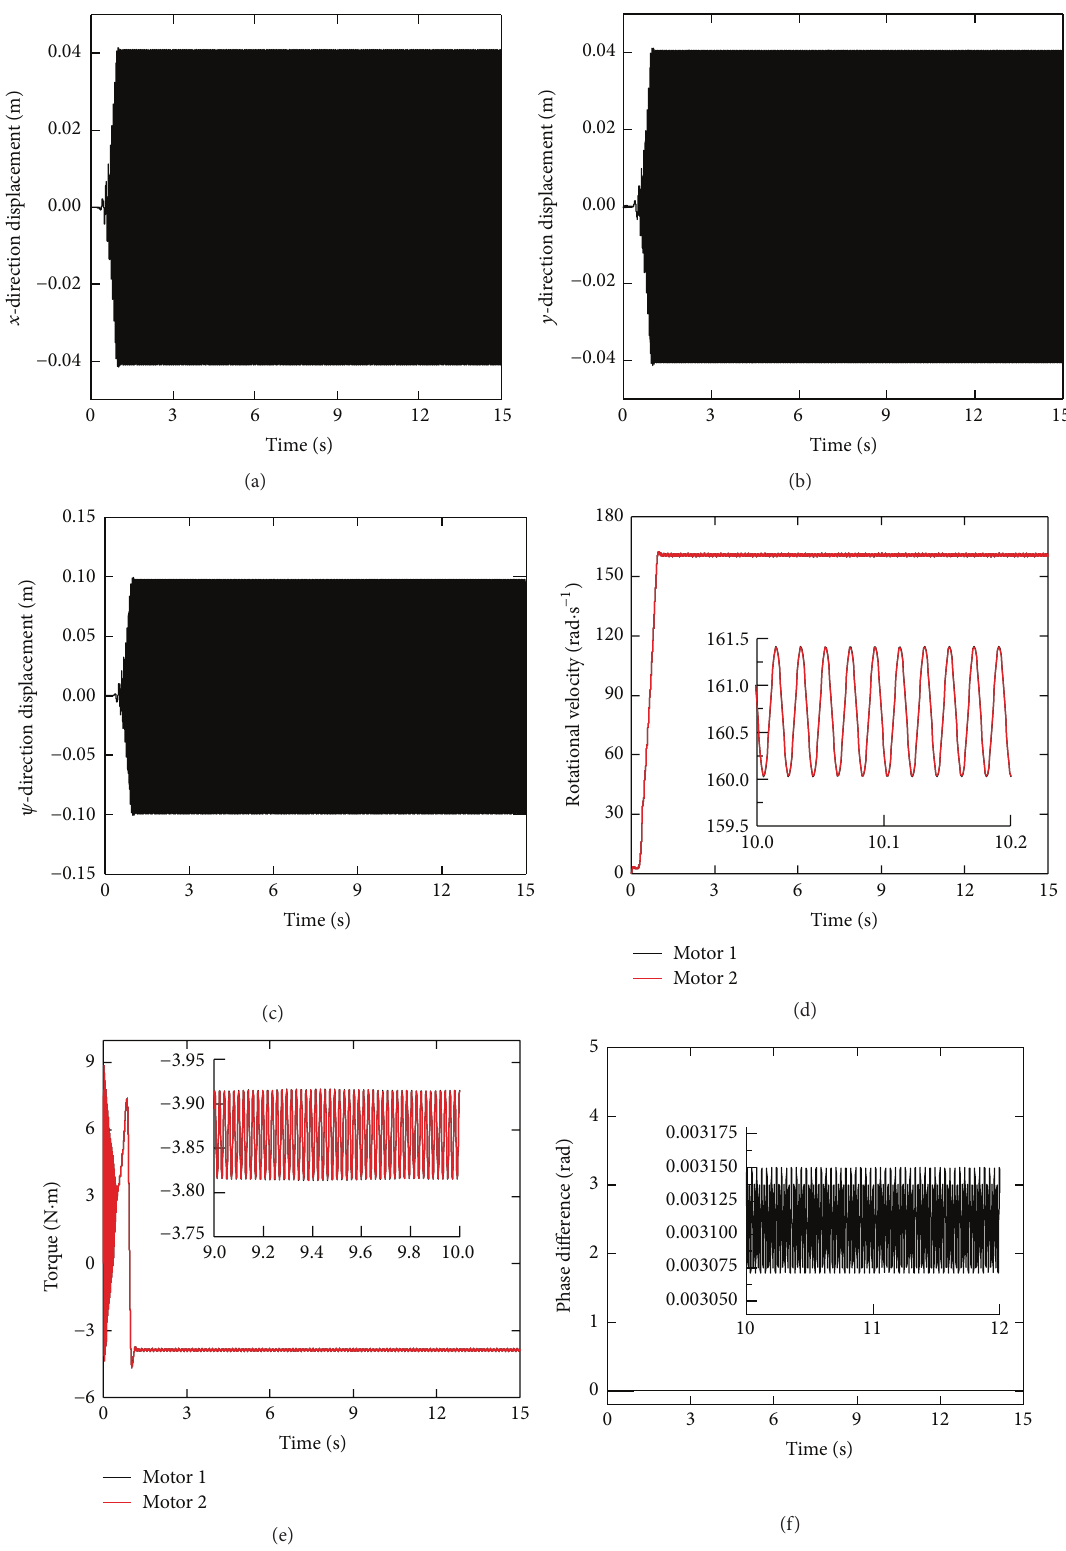
Figure 6: Results for the computer simulation: (a), (b), and (c) displacement responses of the vibrating body in 𝑥 - , 𝑦 - , 𝜓 -directions, respectively; (d) rotational velocities of the two rotors; (e) electromagnetic torques of the two rotors; (f) phase difference of unbalanced